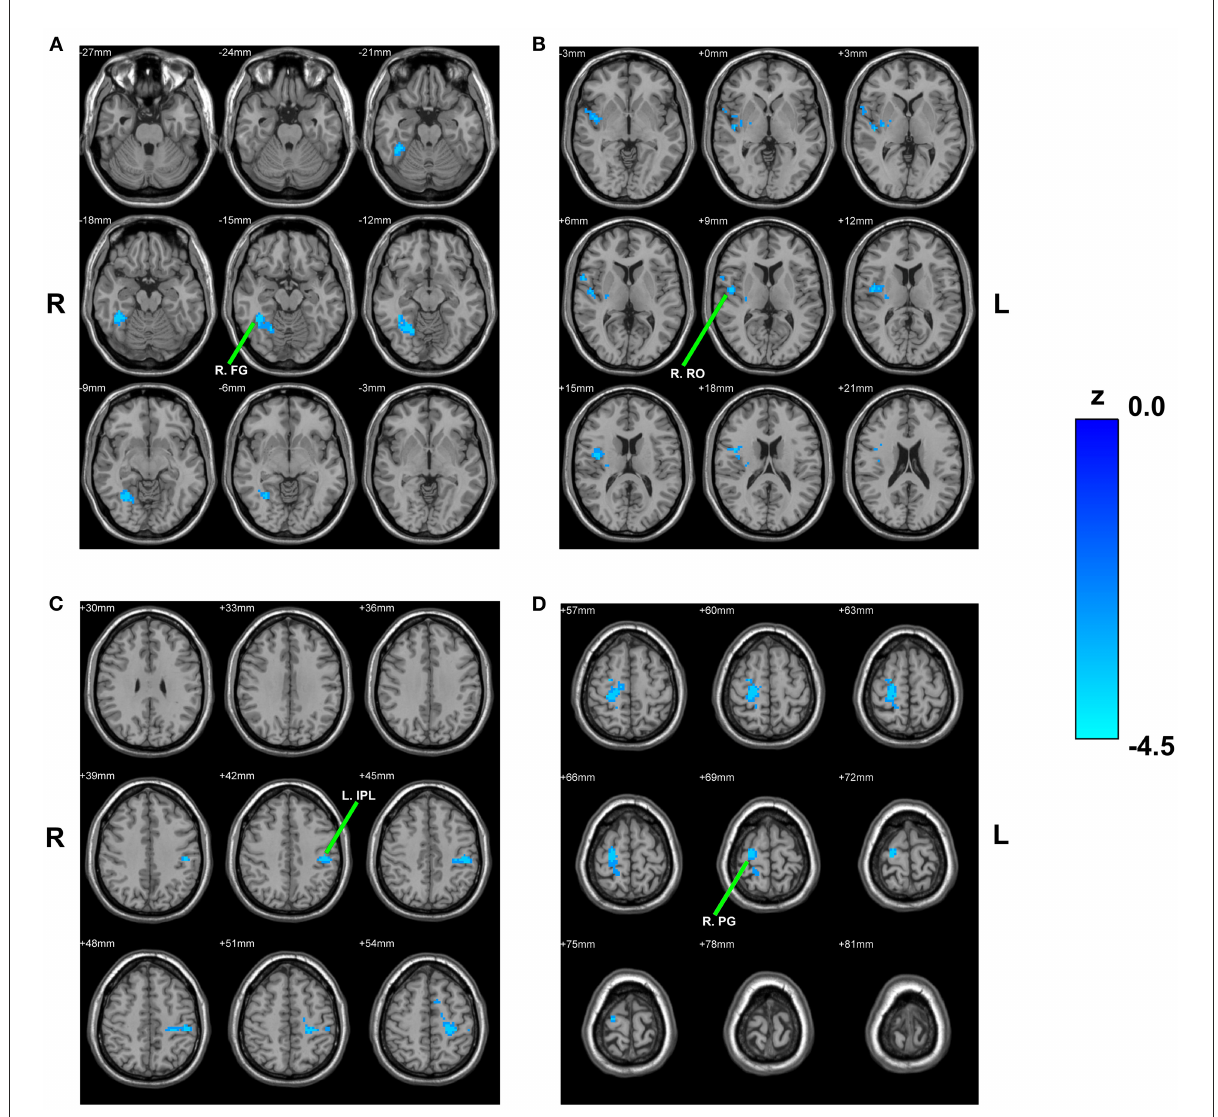
FIGURE2 Between-group comparison based on the left rHipp. The reduced RSFC of the left rHipp with right fusiform gyrus (A) , right Rolandic operculum (B) , left inferior parietal lobule (C) , and right precentral gyrus (D) in children with PNE, respectively. rHipp, rostral hippocampus; PNE, primary nocturnal enuresis; R. FG, right fusiform gyrus; R. RO, right Rolandic operculum; L. IPL, left inferior parietal lobule; R. PG, right precentral gyrus; color bar, z